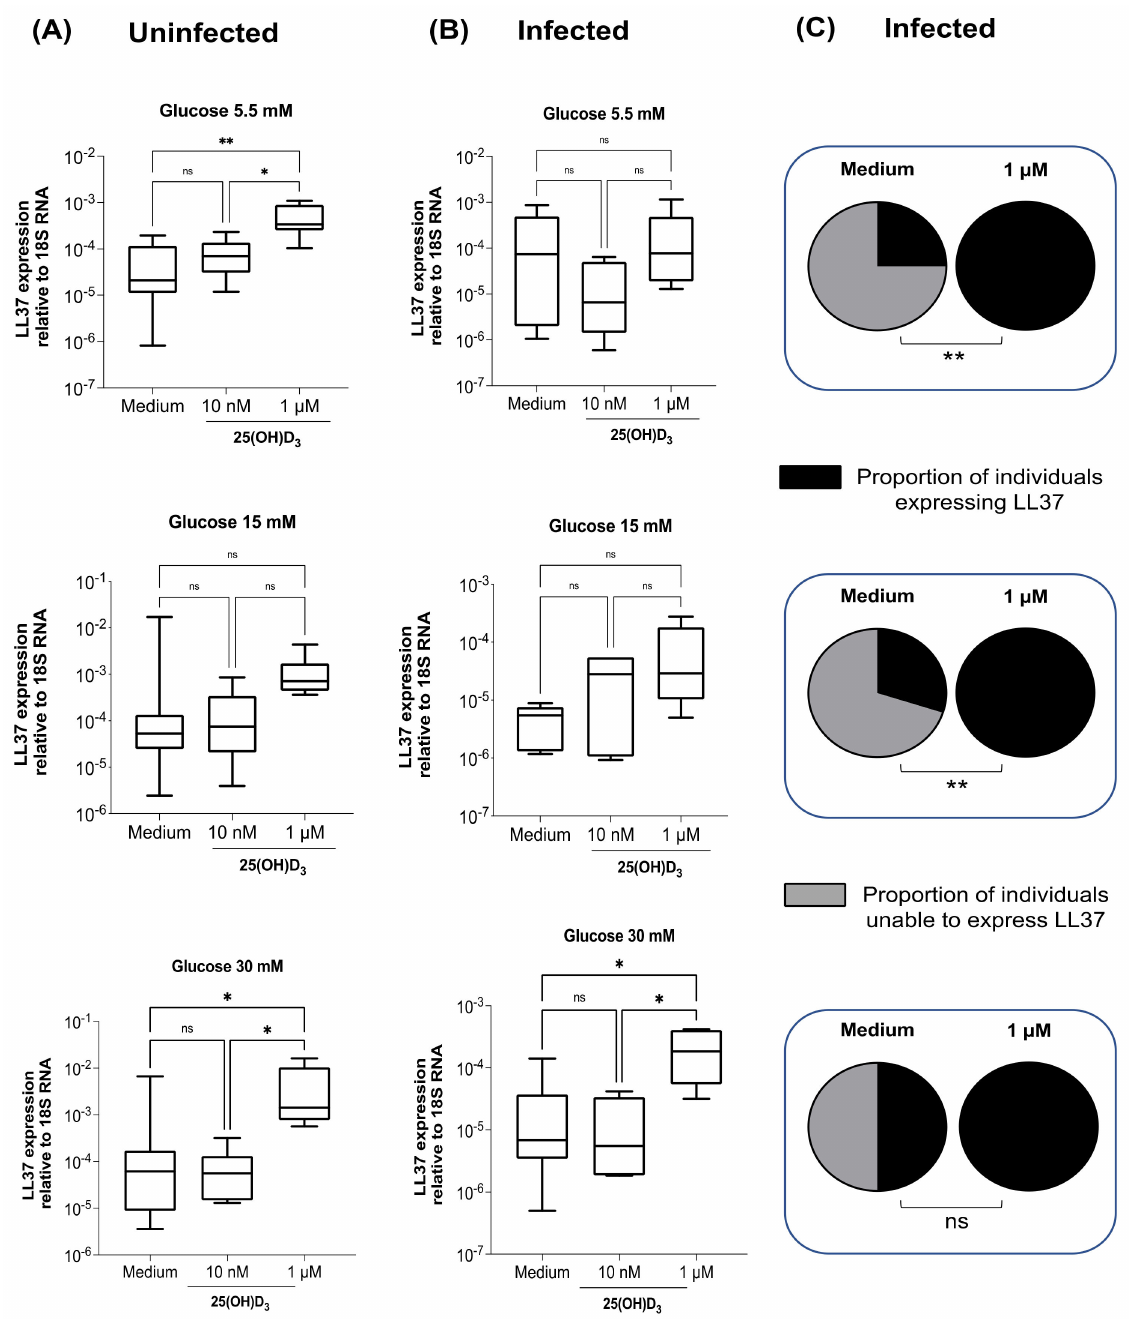
Figure 3. 25(OH)D 3 increases LL37 gene expression in infected macrophages. Macrophages were cultured for 24 h in different glucose concentrations (5.5, 15, or 30 mM) ( A ), or infected with M. tuberculosis (MOI 1), ( B ) supplemented with 25OHVitD (10 nM or 1 µ M), and incubated for an additional 24 h. The macrophages were lysed, and the total RNA was purified and used for cDNA synthesis. LL37 gene expression was measured by qPCR and reported as relative to 18sRNA. Depicted are box plots with medians and quartiles. ns: not significant, * p < 0.01, ** p < 0.001. Medium vs. 25(OH)D 3 (10 nM or 1 µ M), Kruskal-Wallis’ nonparametric ANOVA followed by Dunn’s post-test. Proportion of individuals expressing and unable to express LL37 ( C ); ** p < 0.001, Fisher’s exact test for categorical